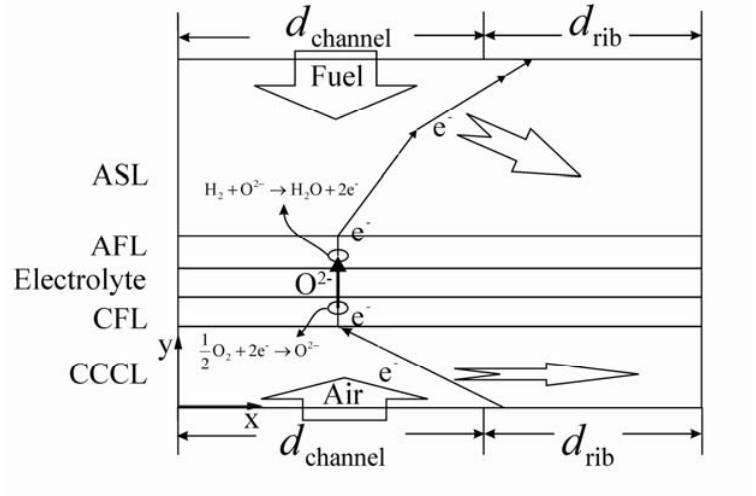
Figure 2. Schematic cross-section model of half repeating unit of SOFC